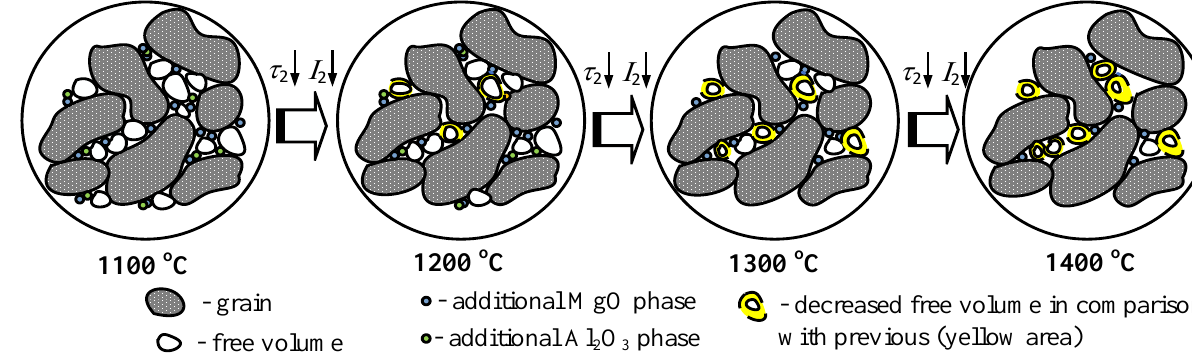
- decreased free volume in comparison with previous (yellow area) - free volume Figure 3. Schematic depiction of the evolution of internal free volume defects at grain boundaries in MgAl 2 O 4 ceramics. The third long component of the PALS spectrum (the second channel of positron annihilation with lifetime τ 3 and intensity I 3 ) is connected to the decay of o-Ps atoms in nanopores and also to the “pick-off” annihilation process [45,48]. As summarized in Figure 2, lifetime τ 3 decreases from 2.59 ns down to 1.9 ns when T s increases from 1100 ◦ C to 1400 ◦ C. At the same time, intensity I 3 remains unchanged and equals 0.02 a.u. Such behavior indicates the decrease of nanopores size and an unchanged overall number of nanopores. Altogether this means more efficient sintering at higher temperatures. The diagram in Figure 4 further explains the evolution of nanopores near grain boundaries in ceramics.